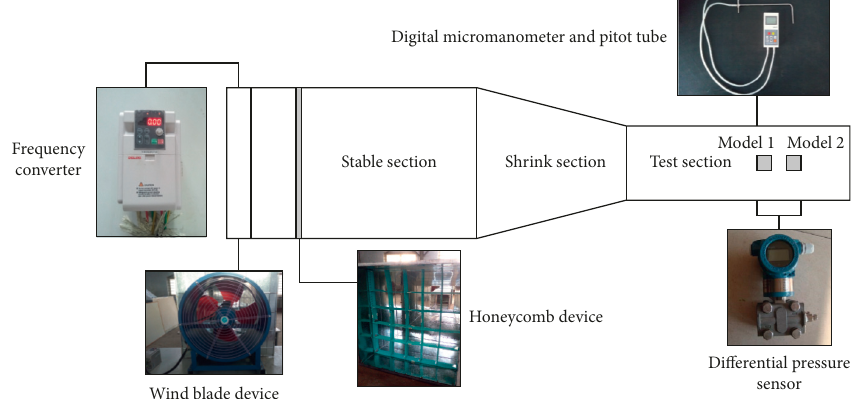
Figure 1: Instruments used in the wind tunnel test.